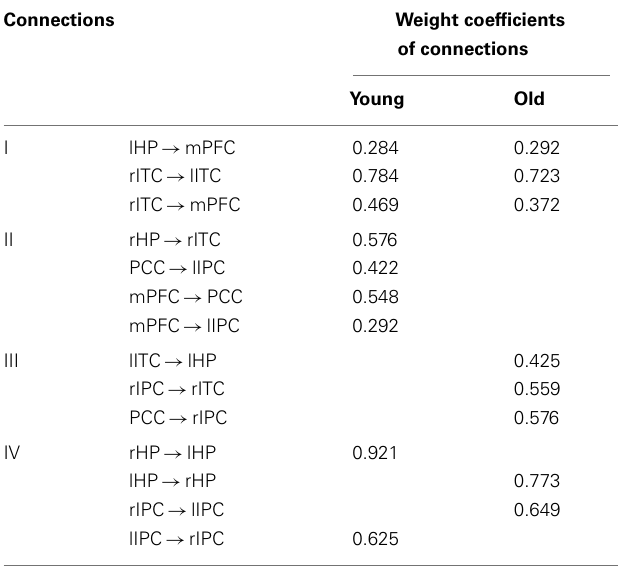
Table 2 | List of connections and the corresponding weight coefficients in the Bayesian network models of the young and old groups .